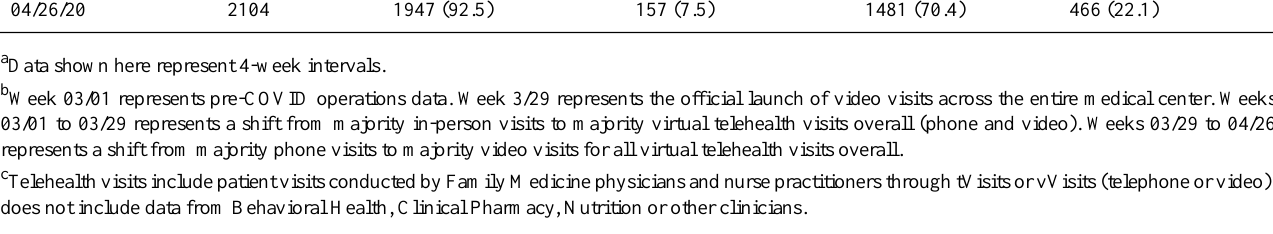
Telephone visits, n (%)Video visits, n (%)In-person visits, n (%)Telehealth visits c , n (%)Visits, NWeek